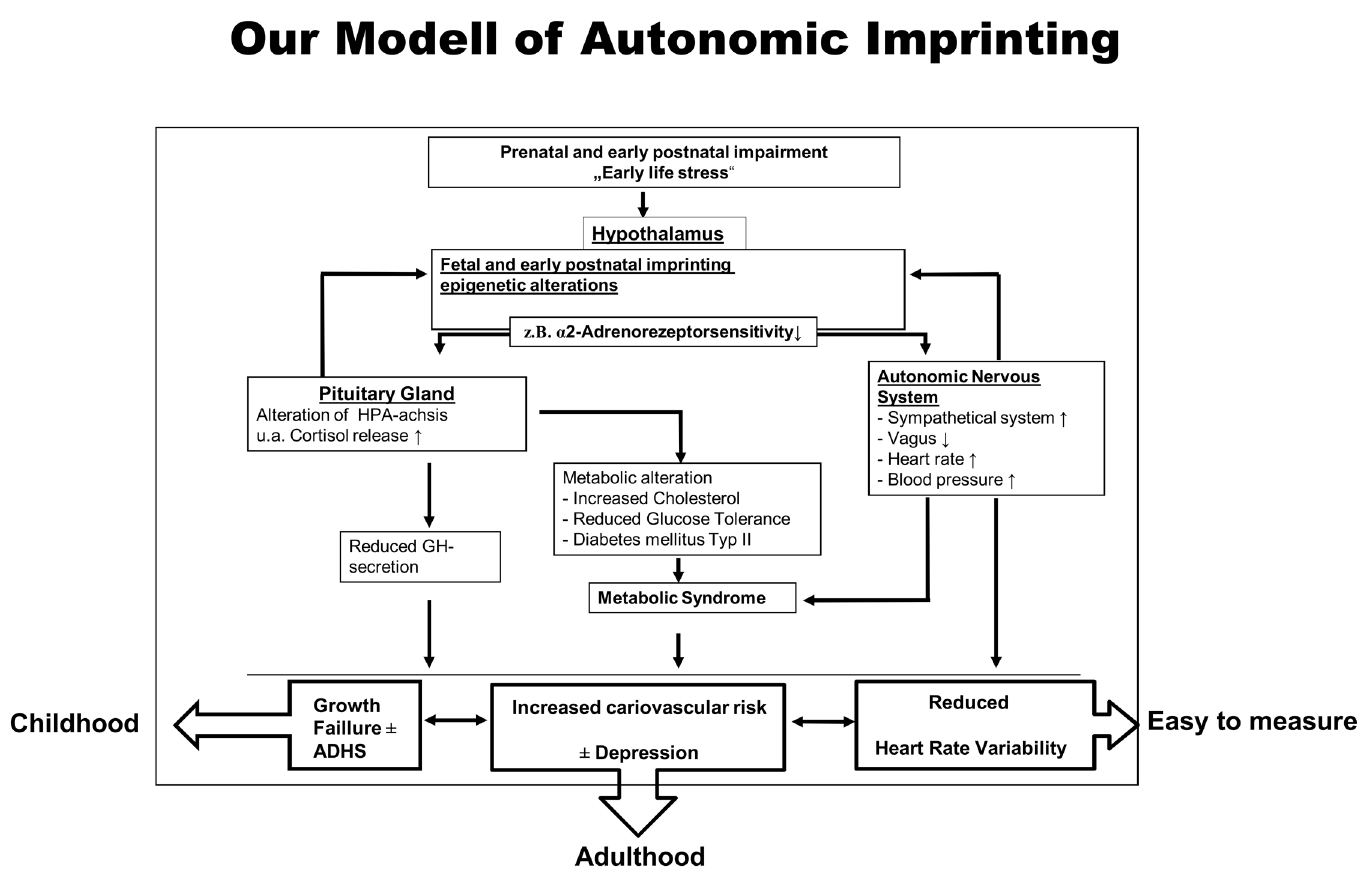
Fig 4. Our model of autonomic imprinting. Early life stress during pregnancy or short time after birth imprints the hypothalamic α 2 -adrenoreceptor. Depending on its regulatory properties the pituitary axis as well as the autonomic nervous system are altered resulting in growth delay, altered adrenal function and reduced